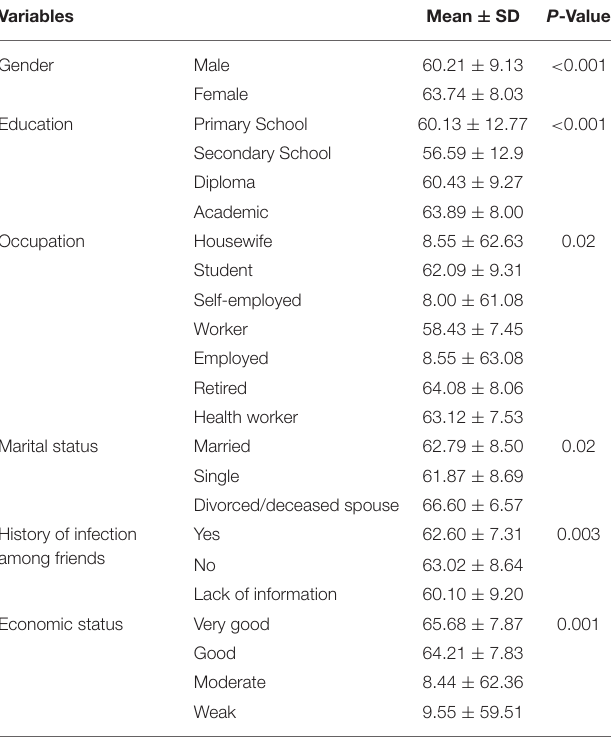
TABLE 3 | The mean score of preventive behaviors based on demographic variables.